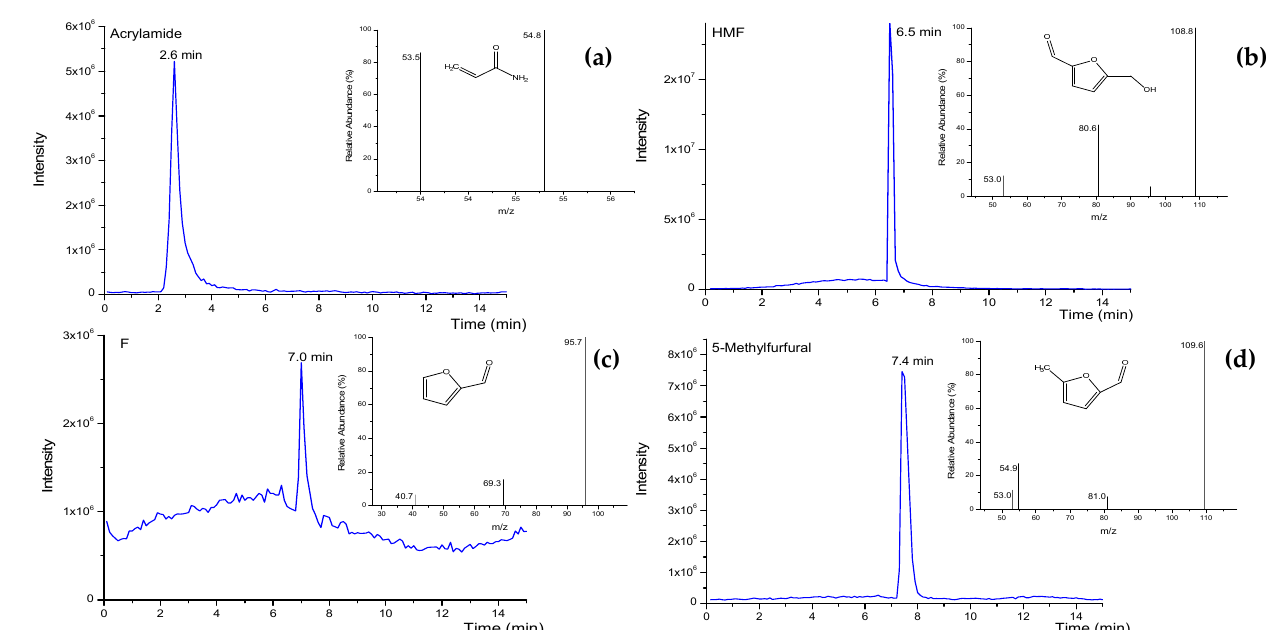
Figure 3. Extracted ion chromatograms obtained in a standard solution mixture of acrylamide (AA), furfural (F), 5-methylfurfural (MF) and hydroxymethylfurfural (HMF) (5 mg/L) in water-MeOH (90:10, v/v ) with optimal gradient. ( a ) Extracted ion chromatogram ( m/z 72.0 > 54.8) and mass spectrum for AA, ( b ) extracted ion chromatogram ( m/z 127.0 > 108.8) and mass spectrum for HMF, ( c ) extracted ion chromatogram ( m/z 97.0 > 95.7) and mass spectrum for F and ( d ) extracted ion chromatogram (m/z 110.9 > 109.6) and mass spectrum for MF.